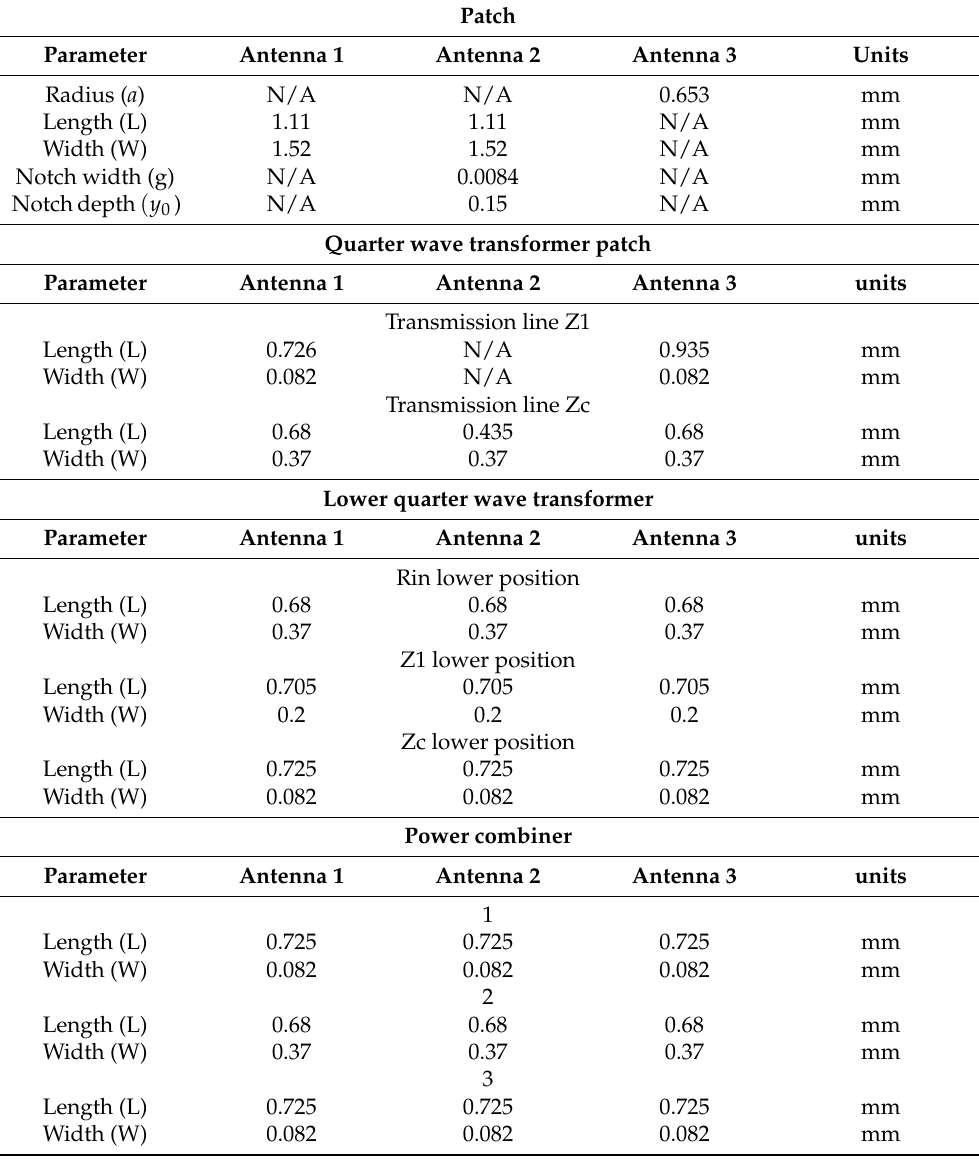
Table 3. Estimated data for the development of